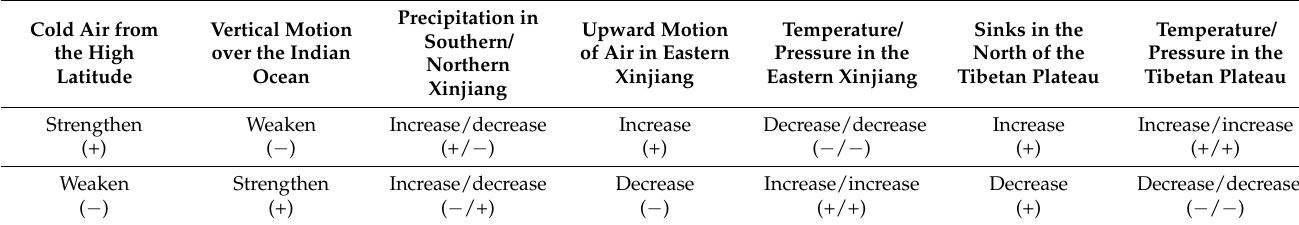
Upward Motion of Air in Eastern Xinjiang Increase (+) Decrease ( − )